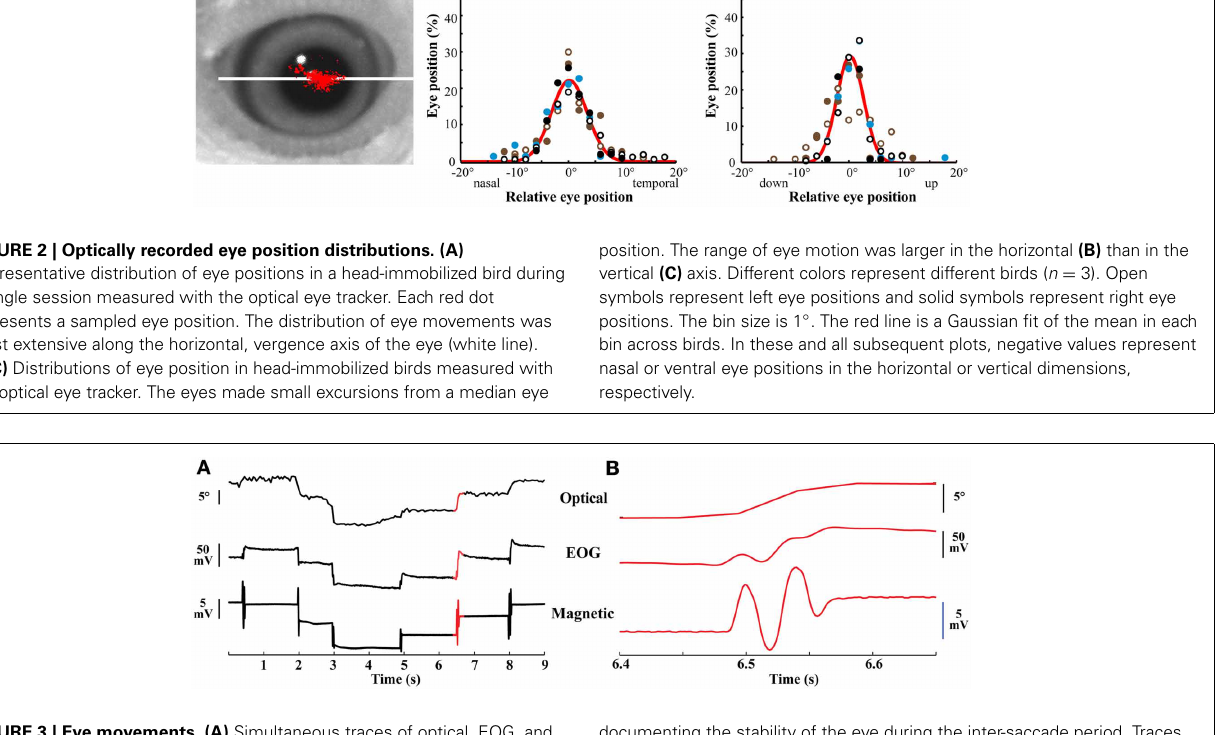
documenting the stability of the eye during the inter-saccade period. Traces sampled at 60, 610, and 610Hz, respectively. Red highlighted region shown in higher resolution in (B) . (B) Higher magnification of the red highlighted region in (A) demonstrating the large amplitude of the eye oscillations.